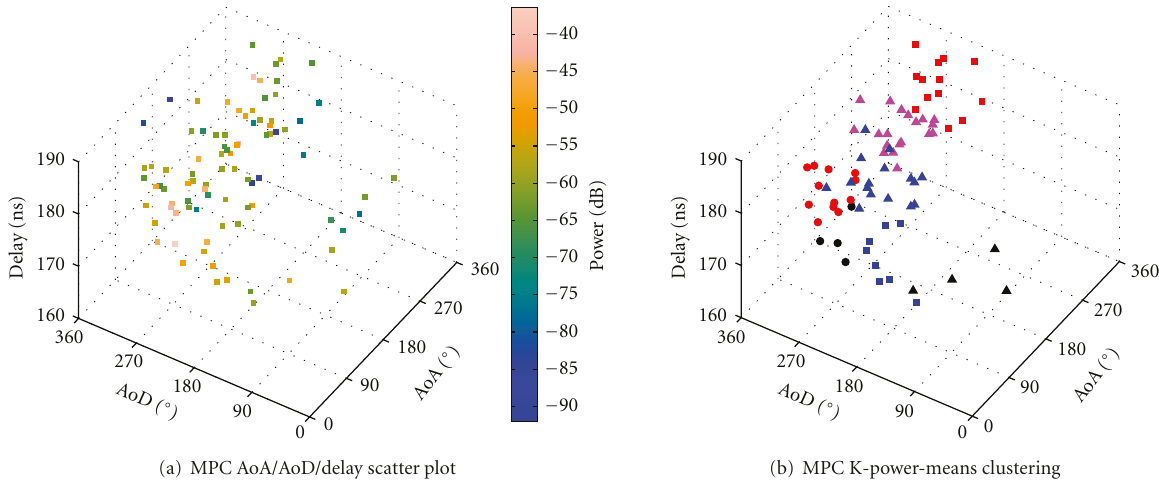
Figure 4: MPC scatter plot and clustering for measurement location 1